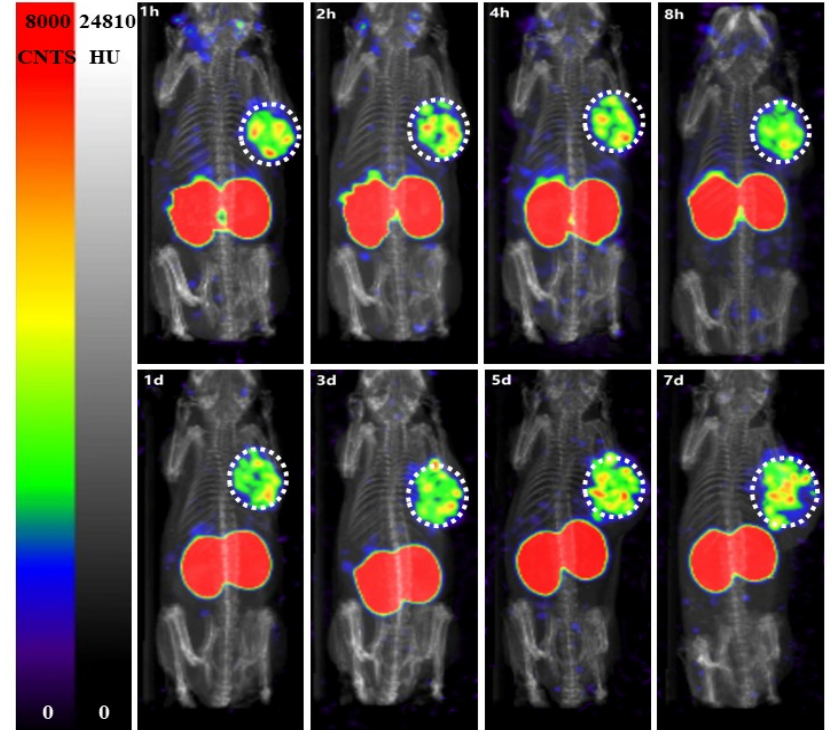
Figure 12. The SPECT images of 125 I-PSMA-7 on nude mice bearing 22RV1 tumors from 1h to 7 d post-injection. The white dotted circle shows the location of the tumor. As the image shows, the tumor remained visible for seven days.